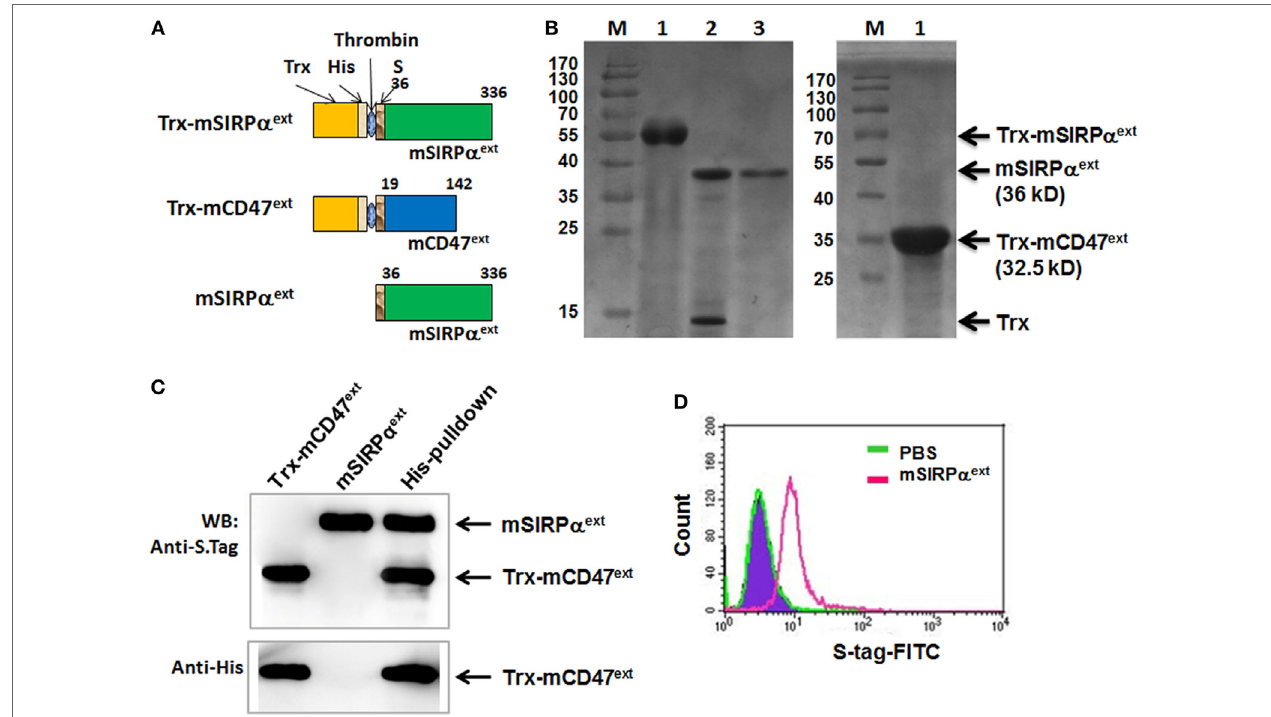
FigUre 6 | Expression and purification of mSIRP α ext fusion proteins. (a) Representative illustrations of the recombinant Trx-mSIRP α ext , Trx-mCD47 ext , and mSIRP α ext proteins. The thioredoxin peptide (Trx), His tag (His), S tag, and the site for thrombin-mediated cleavage are indicated. (B) SDS-PAGE of the purified Trx-mSIRP α ext (left, lane 1), cleaved Trx-mSIRP α ext (left, lane 2), purified mSIRP α ext (left, lane 3), and Trx-mCD47 ext (right, lane 1). The Trx-mSIRP α ext , mSIRP α ext , Trx and Trx-mCD47 ext bands are indicated with arrows, with MW shown in parentheses. M, molecular weight marker. (c) mSIRP α ext interacted with Trx-mCD47 ext in a pull-down assay. The purified mSIRP α ext and Trx-mCD47 ext proteins were incubated in PBS at 4°C for 2 h and were precipitated with anti-His antibody pre-coupled with Dynabeads- protein G. Co-precipitated proteins were analyzed by Western blotting with anti-His or anti-S Tag antibody. Data represent three independent experiments. (D) L1210 cells were incubated with PBS or mSIRP α ext . After washing, cells were stained with FITC-conjugated anti-S tag antibody, followed by FACS